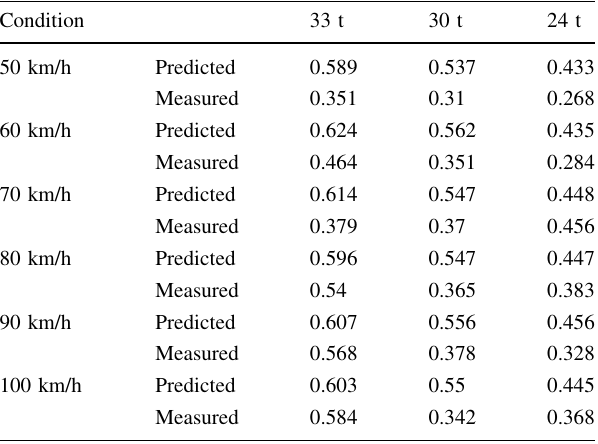
Table 3 Contrast of maximum acceleration of bridge between measured and predicted values (Unit: m/s 2 ) Condition